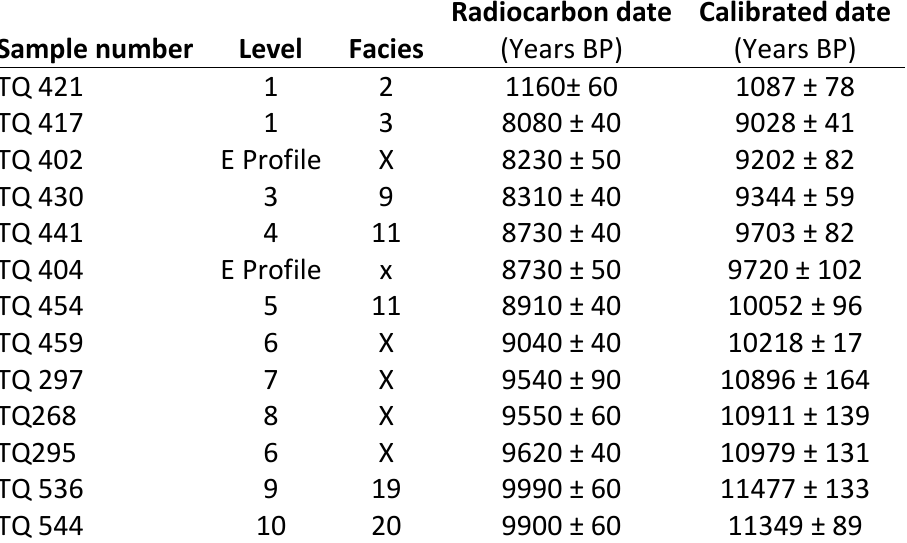
Figure 2. Localization of the Lagoa Santa area and the Lapa Grande de Taquaraçu archaeological site. Modified from Araujo, Neves and Kipnis (2012). Table 1. Calibrated dates from the Lapa Grande de Taquaraçu using the calibration curve CalPal2007_HULU (Danzeglocke et al.